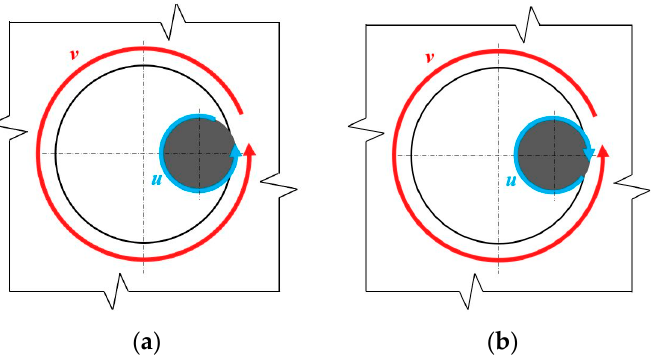
Figure 9. Types of relations between the insert kinematics (deburring) and the drill kinematics (drill- ing); common direction ( a ), opposite direction ( b ). (drilling); common direction ( a ), opposite direction ( b